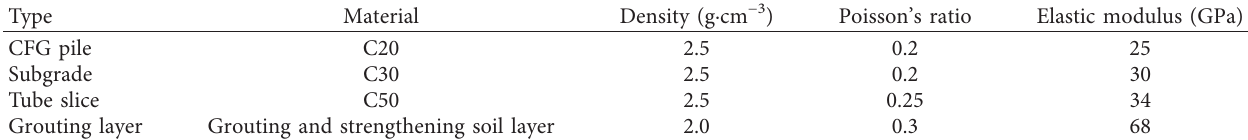
Table 2: Calculating parameters of structural